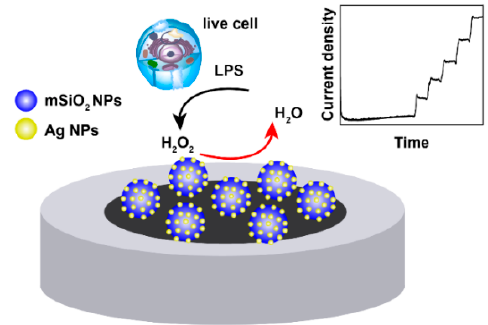
Figure 1. Schematic of electrode modified with silver-mesoporous silica nanoparticles (Ag-mSiO 2 NPs) for H 2 O 2 detection .